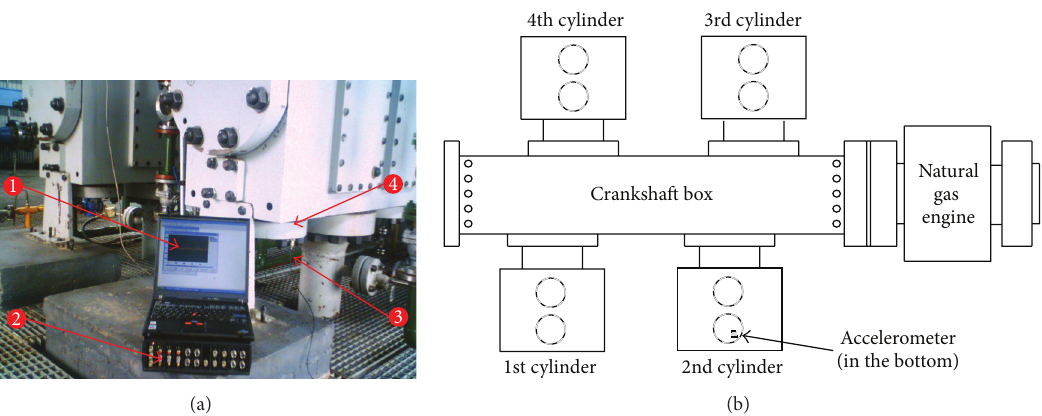
Figure 3: Illustration of experimental setup, (a) data acquisition system, A control panel, B data acquisition box, C accelerometer on the exhaust valve lid, D exhaust valve, and (b) diagram of reciprocating compressor.